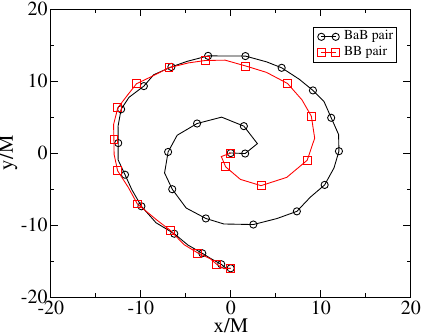
Fig. 24 The position of the center of one BS within an orbiting binary as a function of time for the two cases: (i) [B-B] identical BSs and (ii) [B-poB] opposite phase pair. Notice that the orbits are essentially identical at early times (and large separations), but that they start to deviate from each other on closer approach. This is consistent with the internal structure of each member of the binary being irrelevant at large separations. Reproduced with permission from Palenzuela et al. (2008), copyright by